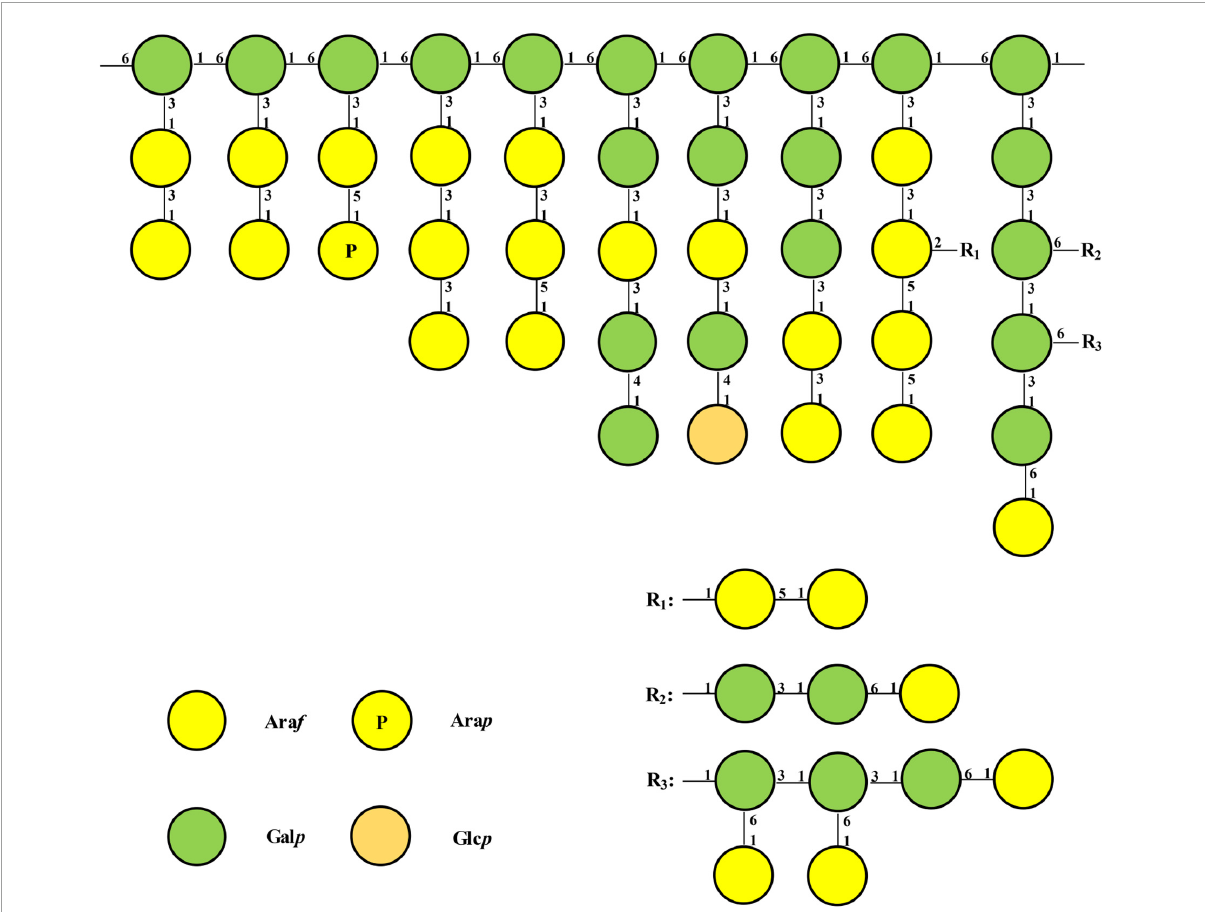
FIGURE5 Model structure of possible repeating unit of LFP-80-W1. Only one possible structure was shown, and the connected chains can be arranged in other reasonable orders.